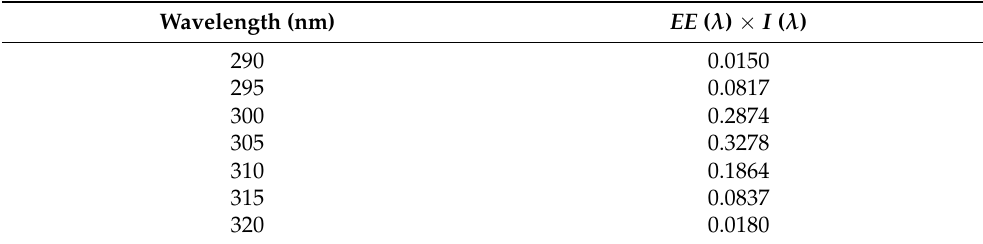
Table 1. Values of EE ( λ ) × I ( λ ) used in the SPF